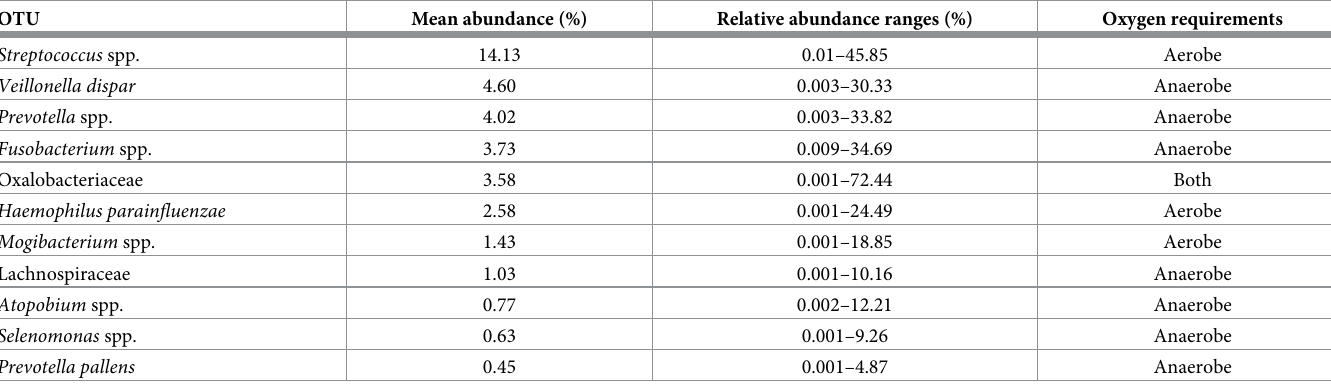
Table 3. The most prevalent OTUs across samples (90–100% patients) in descending order of mean abundance (%). OTU Mean abundance (%) Relative abundance ranges (%) Oxygen requirements Streptococcus